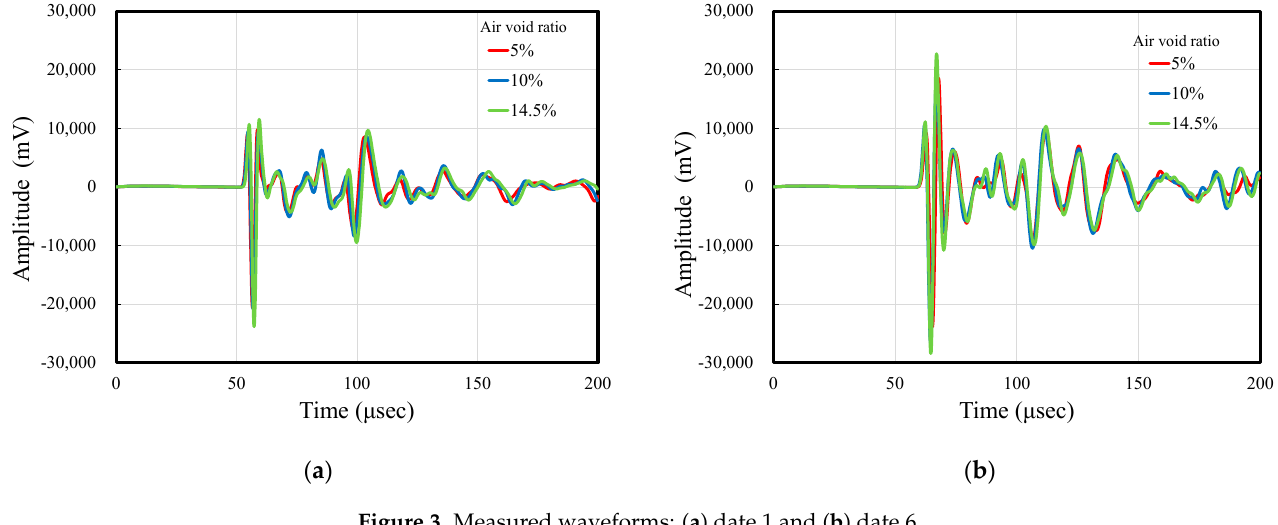
Figure 3. Measured waveforms: ( a ) date 1 and ( b ) date 6.